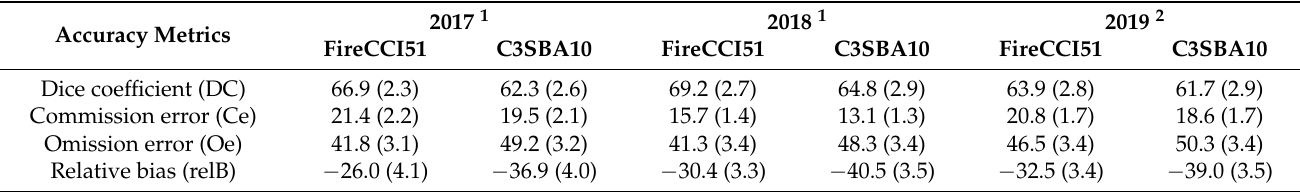
Table 5. Accuracy metrics for the years 2017, 2018 and 2019. Standard errors are shown between parentheses.